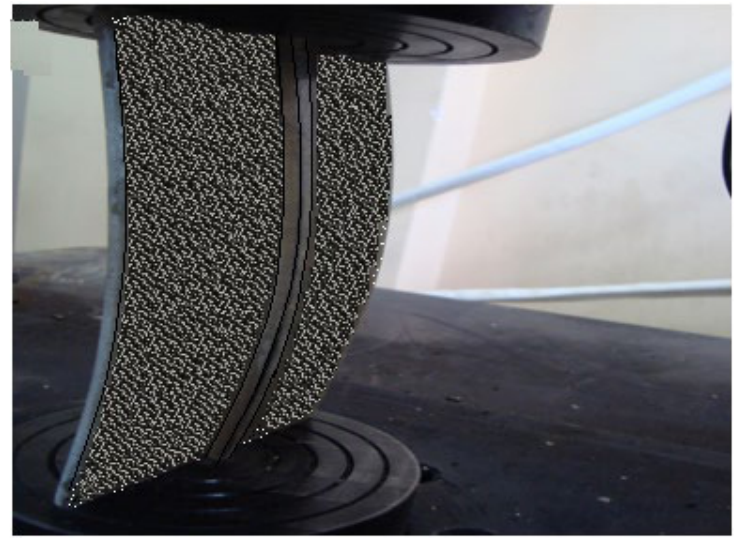
Figure 5. Rectangular plate with one stiffener.